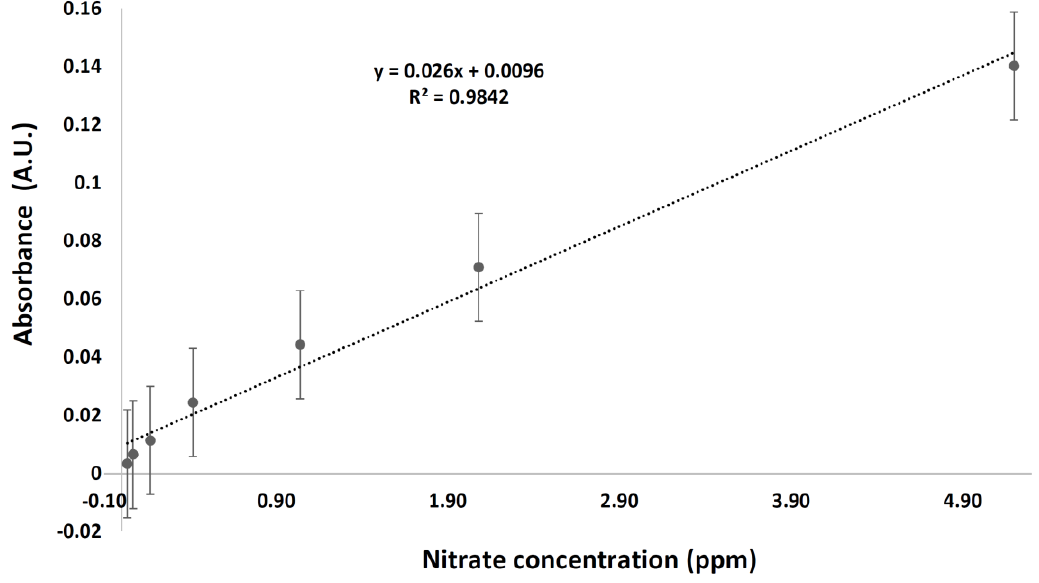
Figure 4. Calibration curve for the prepared standard solutions.